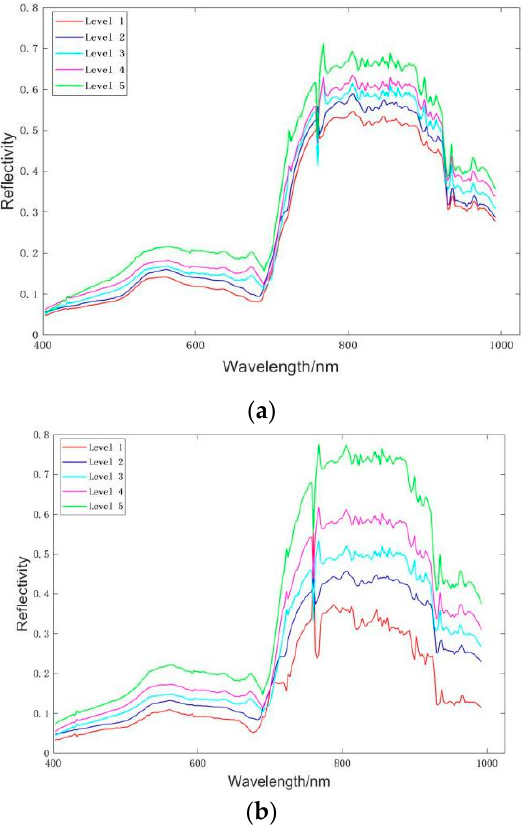
Figure 5. Spectral information. ( a ) Original spectral curve; ( b ) Spectral curve after pretreatment.